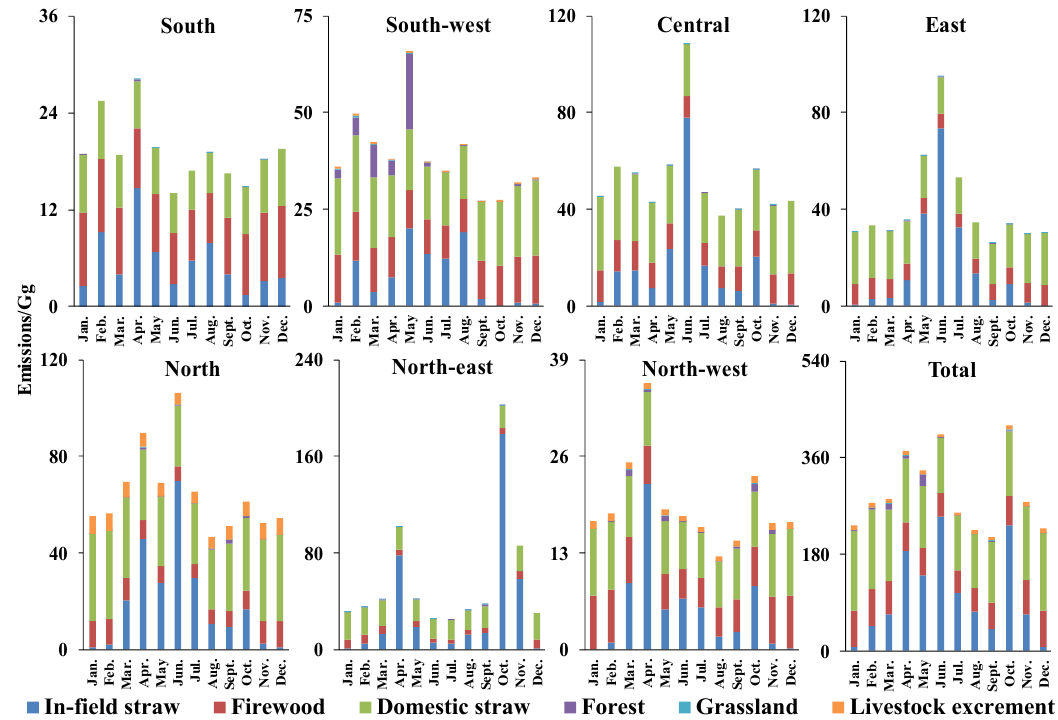
Figure 9. Monthly variation of different biomass sources emission for PM 2 . 5 emissions in different